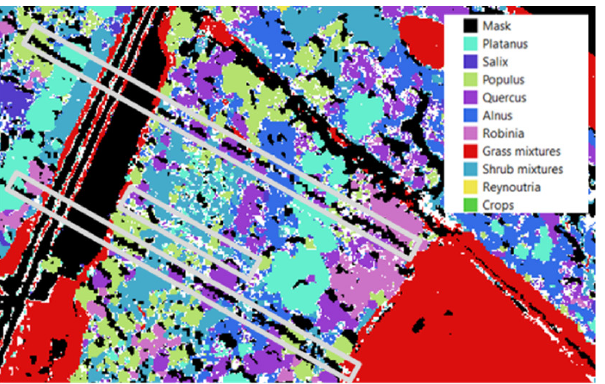
Figure 9. Subset of RLR-ℓ1 map with rejection class (in white). Electrical lines are framed in gray.